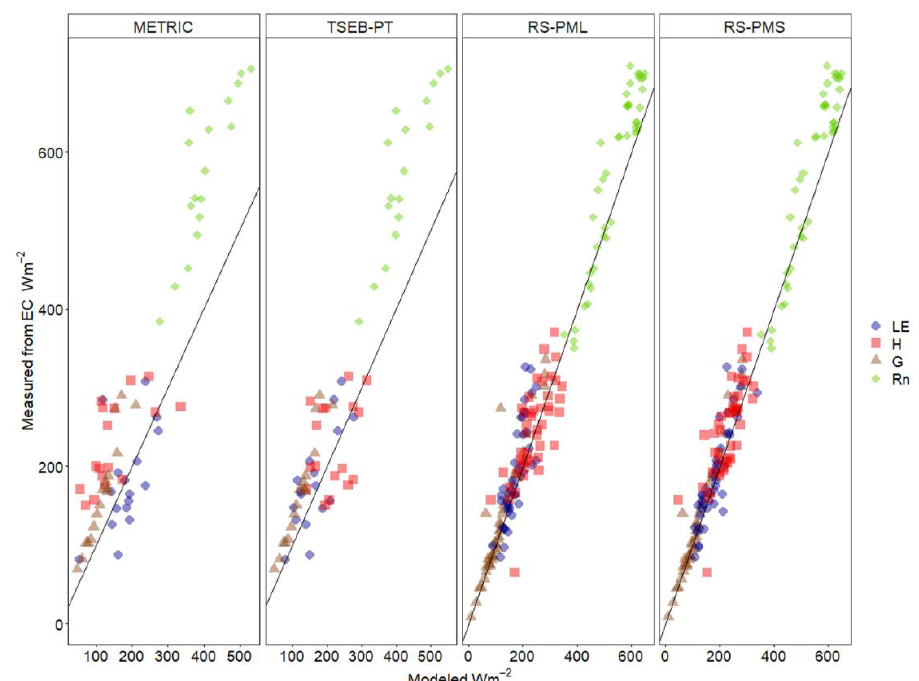
Figure 9. Regression analysis and 1:1 line (solid line) between measured by eddy covariance (EC) and modeled energy balance components by Mapping Evapotranspiration at High Resolution with Internalized Calibration (METRIC), Priestley–Taylor Two Source Energy Balance (TSEB-PT), Remote Sensing Penman-Monteith–Leuning (RS-PML) and Remote Sensing Penman-Monteith–Stewart (RS-PMS). Table 5. Model comparison of estimations of evapotranspiration at different temporal